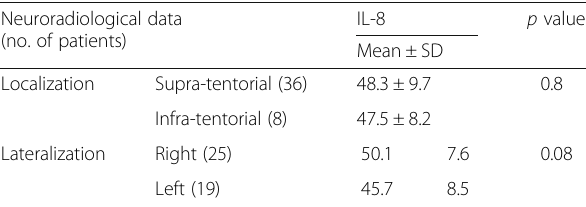
Table 2 Comparison of the serum level of IL-8 in different radiological